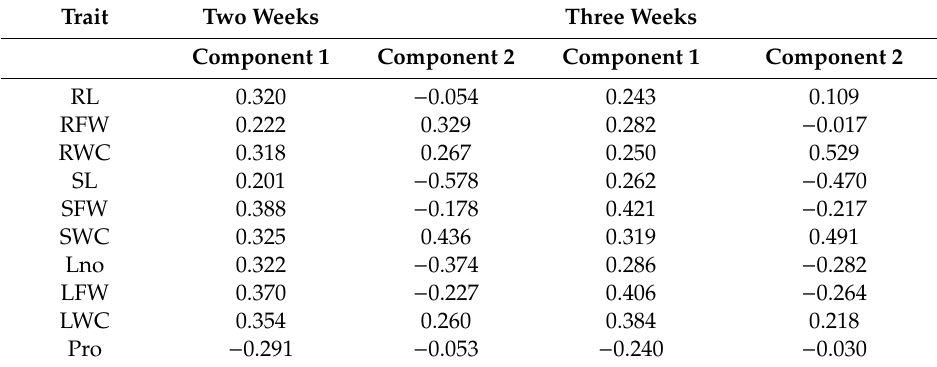
Table 4. Component weights in the PCA performed on cultivars subjected to two and three weeks of treatment. Abbreviations: RL, root length; RFW, root fresh weight; RWC, root water content; SD, stem diameter; SL, stem length; SFW, stem fresh weight; SWC, stem water content; Lno, leaf